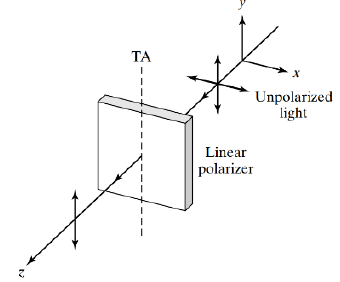
Figure 1 . Operation of a linear polarizer (Pedrotti et al., 2017) Polarized images can be taken at different angles using a polarizing filter located in the front of the digital camera and rotated. Using these polarization images, information such as azimuth and zenith angle can be obtained which leads to estimation of surface